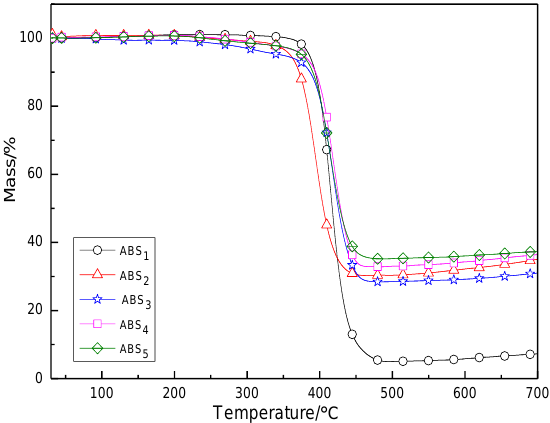
Figure 6. TGA curves of ABS and ABS composites.